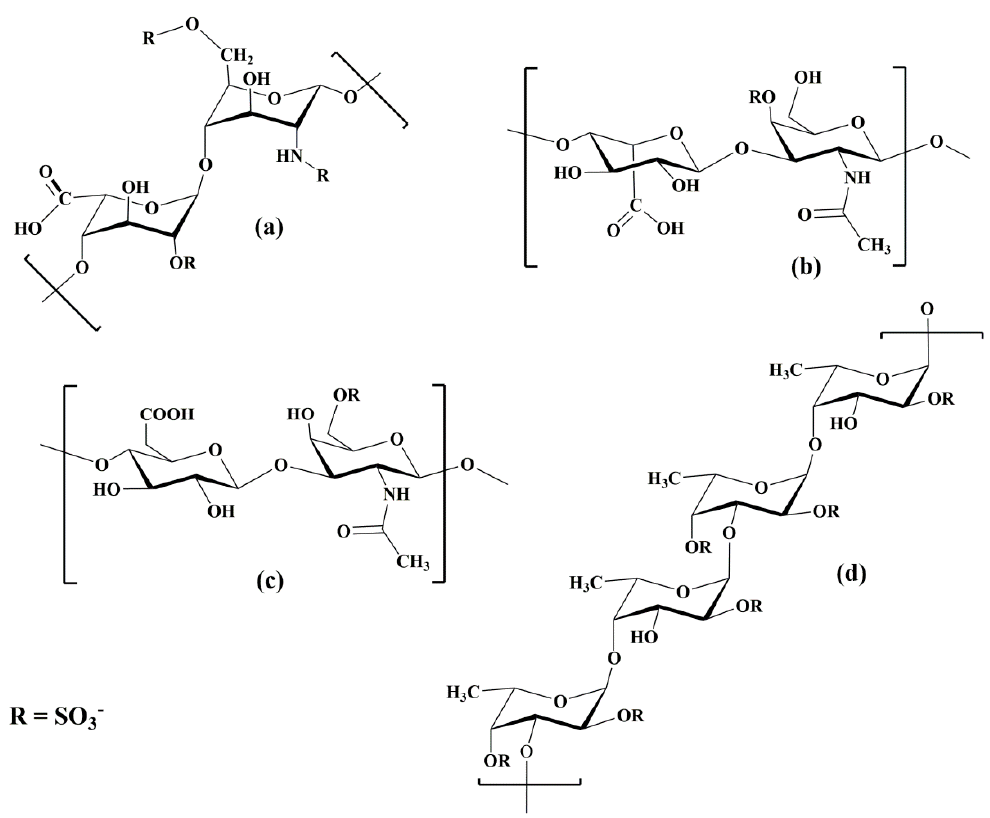
Figure 13. Schematic representation of natural sulfated polysaccharides with inhibitory activity against selectins; ( a ) heparin, ( b ) dermatan sulfate, ( c ) chondroitin sulfate, and ( d ) fucoidan.